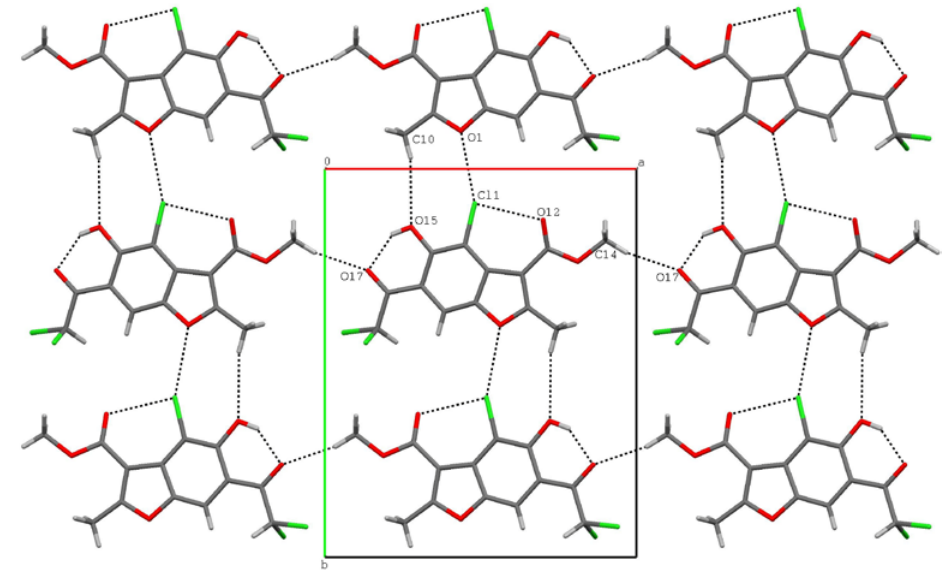
Figure 7. The interconnections within a layer for VI .